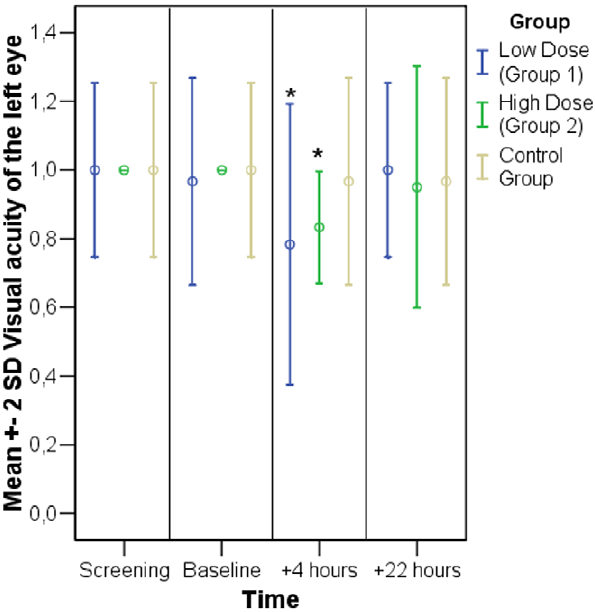
Figure 1. Visual acuity. Time course of mean values + / 2 2 * standard deviation for 6 subjects of each group. A significant deterioration compared to baseline was observed in both verum groups 4 hours after treatment (asterisked bars). As the pupil of the right eye was dilated acuity testing was only performed in the left eye.